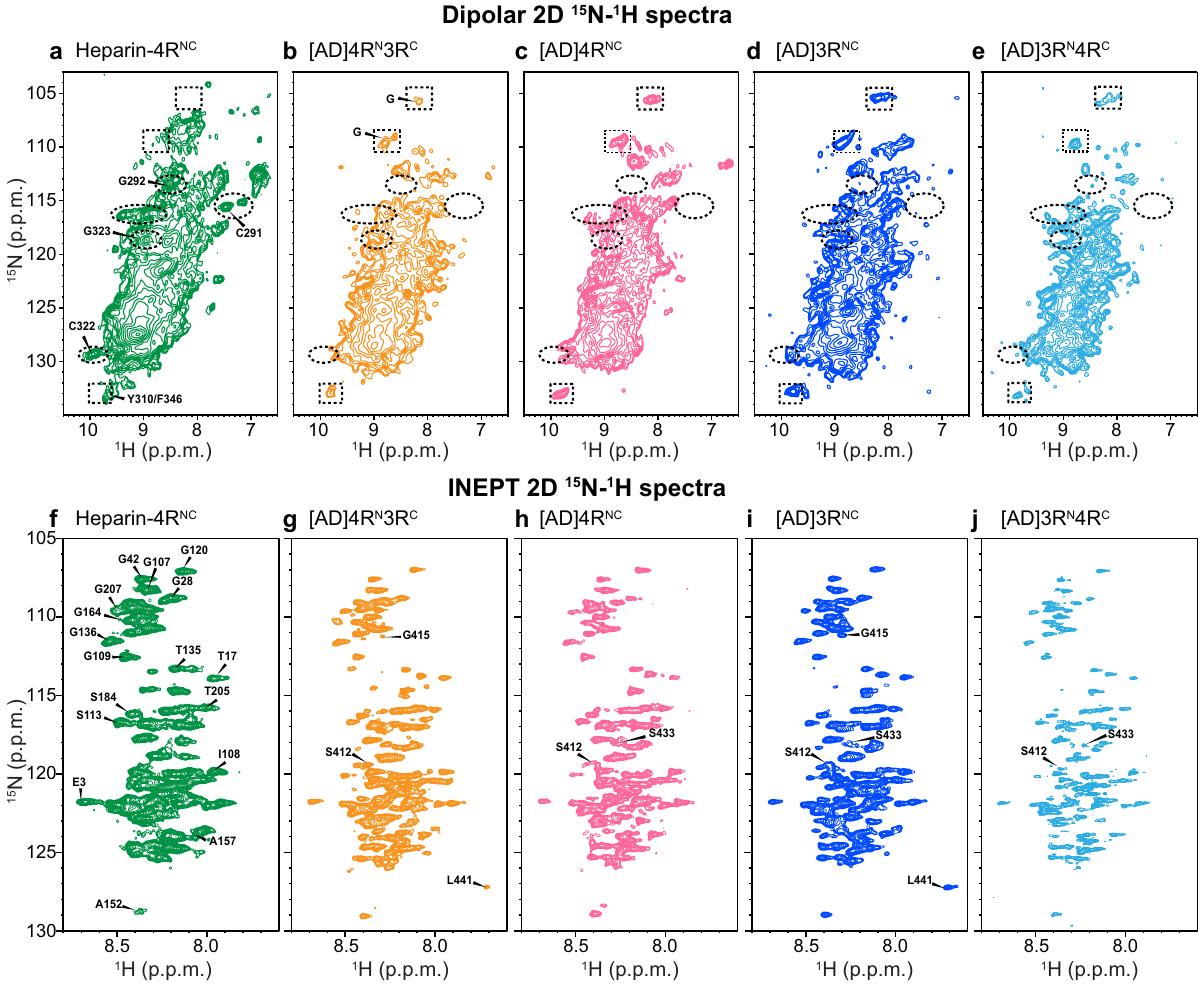
Fig. 4 2D 15N-1H correlation spectra of AD-tau-seeded fi laments show isoform-independent molecular conformation and dynamics that differ from heparin- fi brilized tau. a – e 2D dipolar correlation spectra indicate a common rigid-core structure for all isoforms in AD seeded tau. a Heparin- fi brillized 0N4R tau. Several assignments based on 3D hCANH and hCA(co)NH spectra are indicated (Supplementary Fig. 7). b AD-tau seeded 15 N-labeled 4R tau mixed with 13 C-labeled 3R tau (1:1). c AD-tau seeded 15 N, 13 C-labeled 4R tau. d AD-tau seeded 15 N, 13 C-labeled 3R tau. e AD-tau seeded 15 N-labeled 3R tau mixed with 13 C-labeled 4R tau (1:1). Examples of peaks that are present in heparin- fi brillized tau but not in AD seeded tau are indicated by dashed ovals, while peaks that are present in AD seeded tau but not in heparin- fi brillized tau are indicated by dashed rectangles. f – j 2D INEPT spectra indicate similar dynamic segments for all isoforms in AD-seeded tau. Assignments for clearly resolved peaks are transferred from refs. 29,46 . f Heparin- fi brillized 0N4R tau. g AD-tau-seeded 15 N-labeled 4R tau mixed with 13 C-labeled 3R tau. h AD-tau-seeded 15 N, 13 C-labeled 4R tau. i AD-tau-seeded 15 N, 13 C-labeled 3R tau. j AD-tau seeded 15 N-labeled 3R tau mixed with 13 C-labeled 4R tau. Peaks from residues from the N-terminus to G207 are present in all samples, whereas C-terminal residues show varying intensities among the